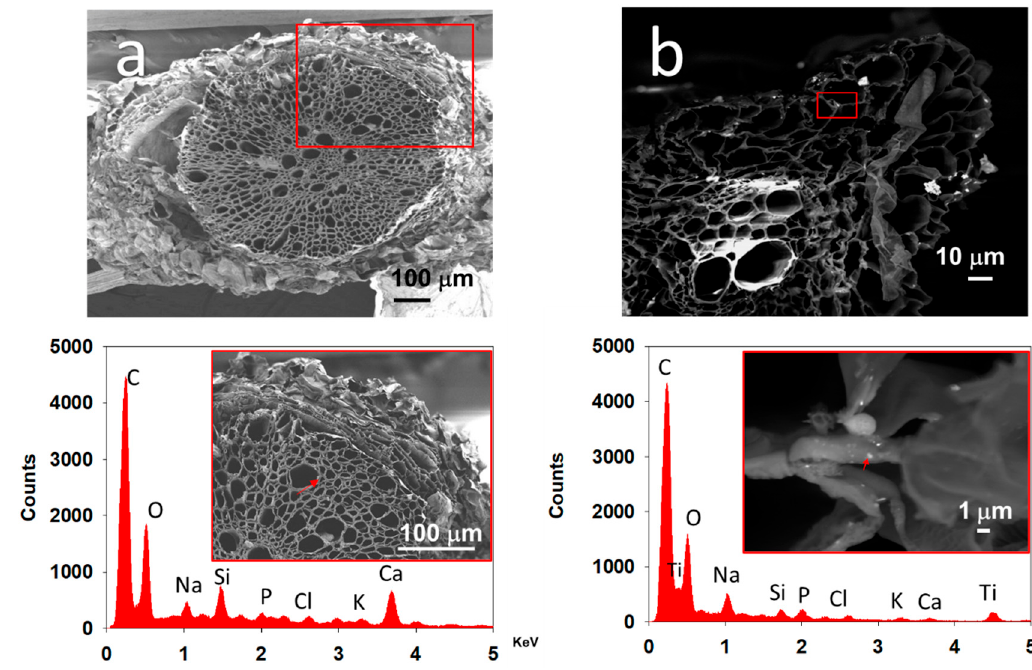
Figure 10. Element detected by SEM/DLS in tomato ( a ) root control and ( b ) exposure at 20 mg/L TiO 2 NPs. After 21 days of exposure to 20 mg/L TiO 2 NPs, tomato root cells showed TiO 2 NPs inside the cells near to cell wall, this could be observed by image analysis of TEM. Figure 11 shows the incorporation of TiO 2 NPs inside the vegetal cell of the tomato root.